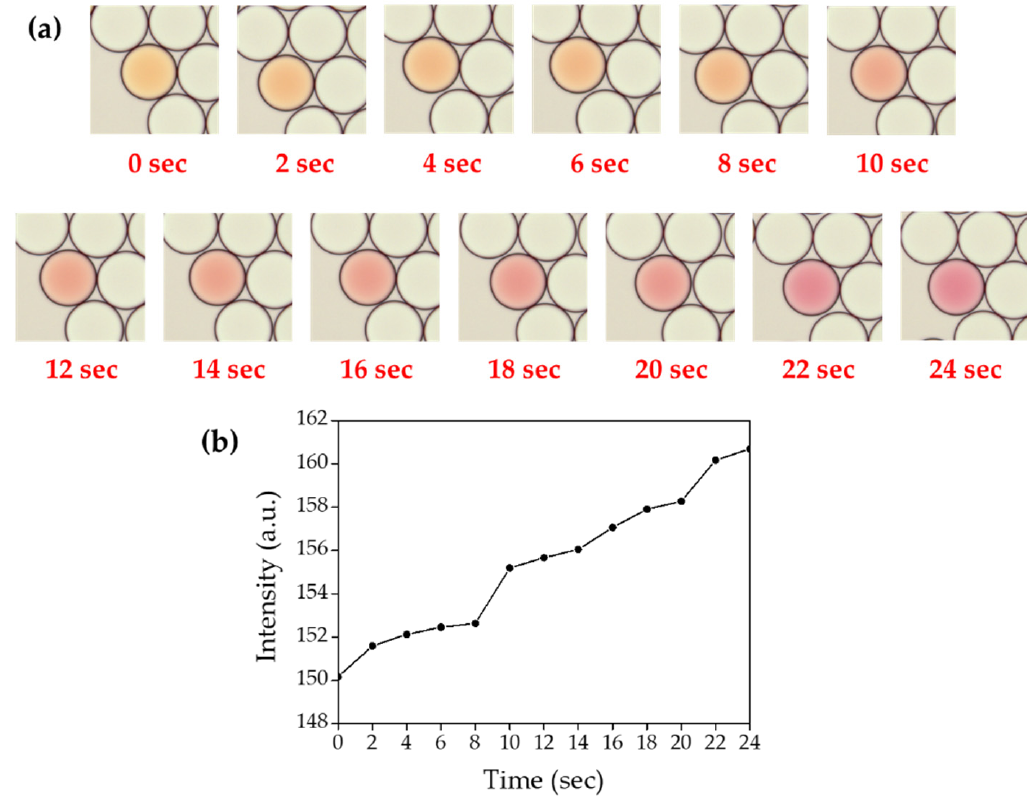
Figure 15. Time-course measurement of ammonia gas crosstalk between droplets. ( a ) Microscopic images of droplet mixture between indicator droplet and ammonia gas generating droplets, the video was recorded for 24 s under DMi-8 microscope. ( b ) Mean values of color change in the indicator droplets.